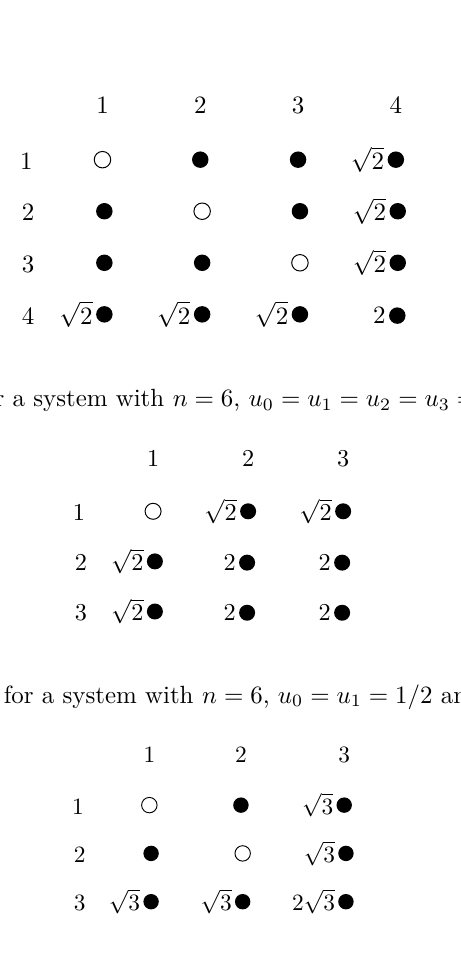
Figure 5 . Lattice for a system with n = 6 , u 0 = u 1 = u 2 = 1 / 2 and u 3 = 3 / 2